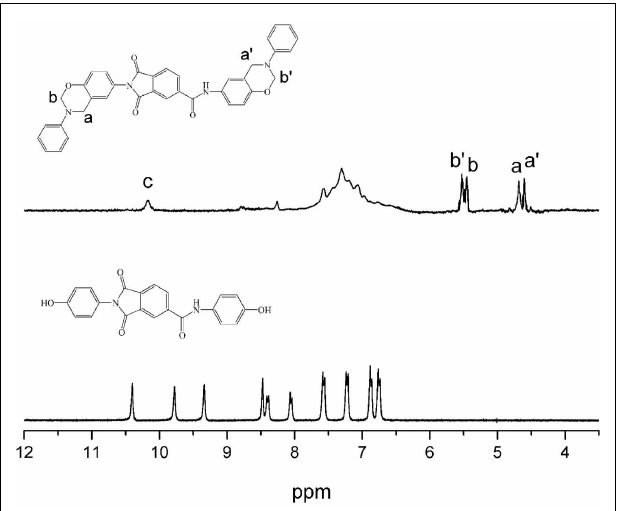
FIGURE 3 | Fourier transform infrared spectra of benzoxazine monomers